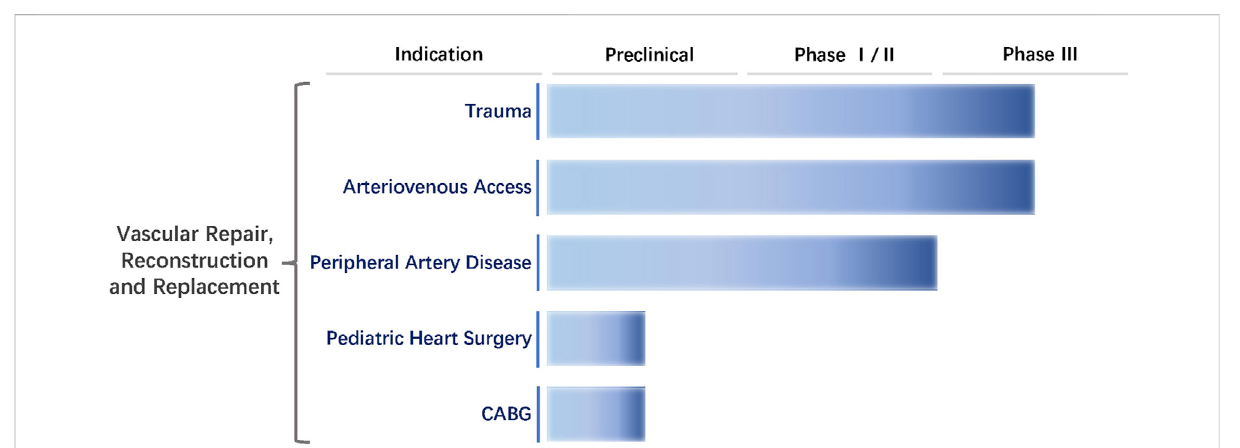
FIGURE 6 Clinical trialsofHumacyte, Inc.The clinicaltrialsconductedby thecompany for thetreatment of trauma andarteriovenous access are inPhase Ⅲ .PeripheralvascularbypassgraftinghascompletedPhase Ⅱ .Pediatricheartsurgeryandcoronaryarterybypassgrafting(CABG)areinthepreclinical